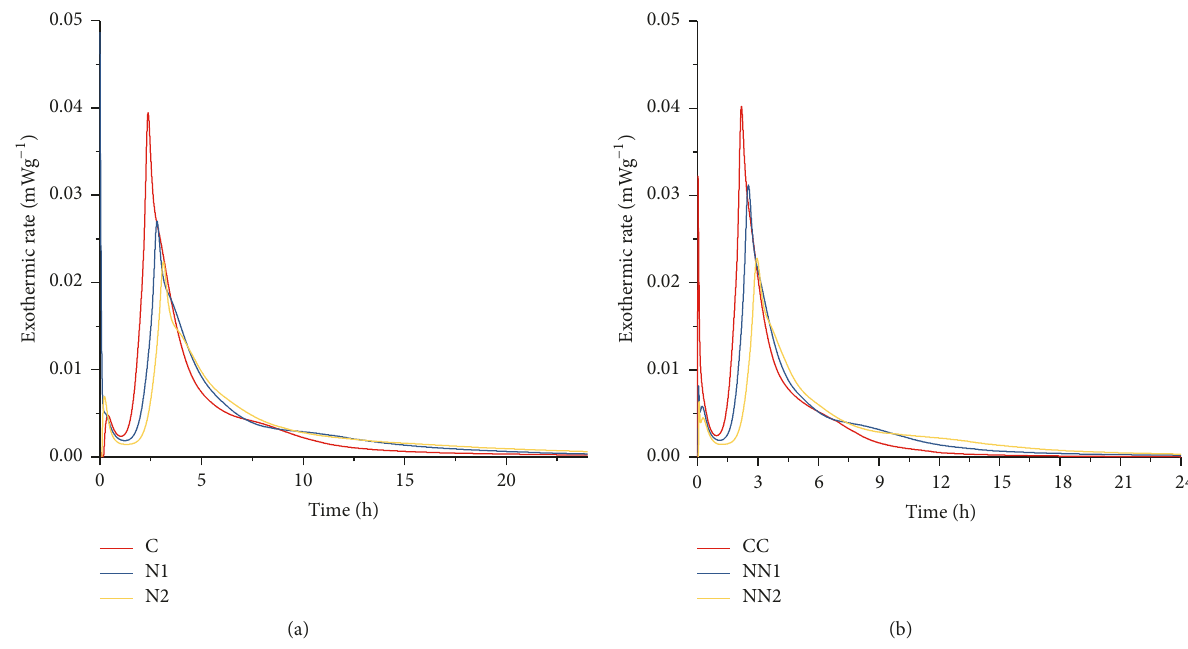
Figure 5: (a) Exothermic rates during the hydration of samples C, N1, and N2 at 80 ∘ C. (b) Exothermic rates during the hydration of samples CC, NN1, and NN2 at 80 ∘